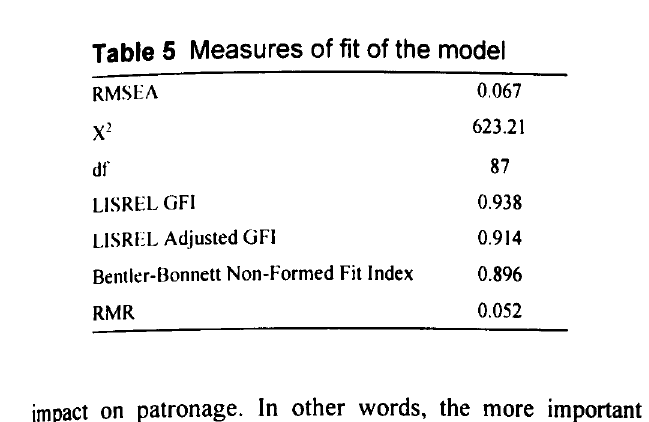
Table 5 Measures of fit of the